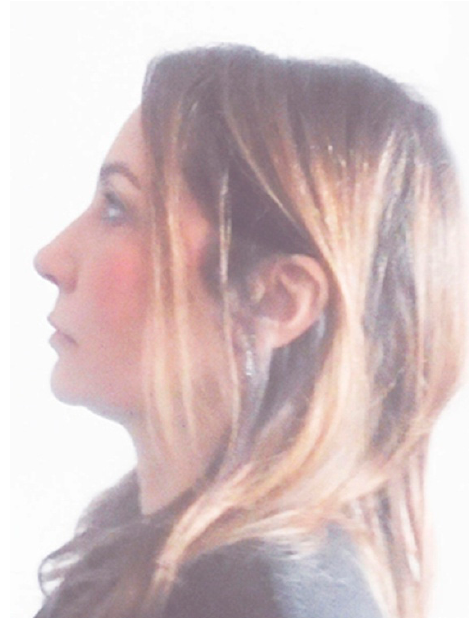
Figure 7. Profile. Figure 7.